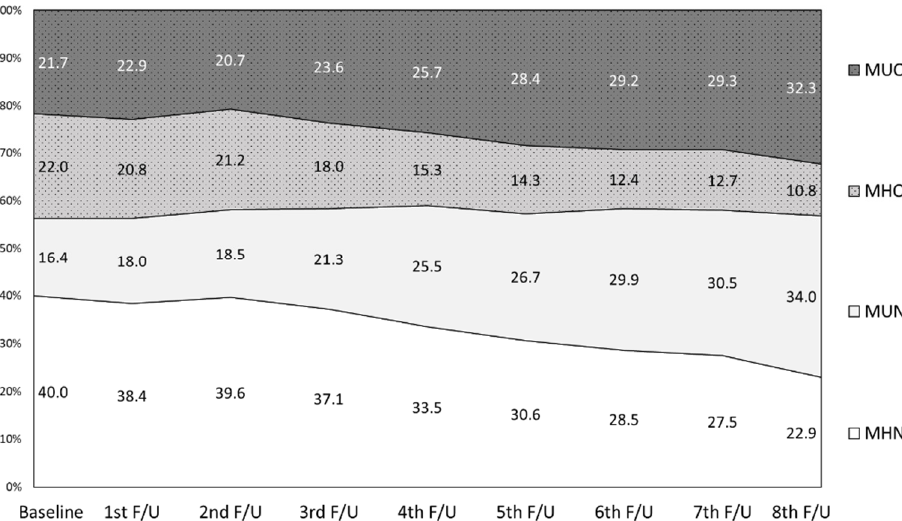
Figure 2. Transition of the combination of metabolic health risk and obesity during the follow-up period. Data were analyzed for those that had data for baseline and all 8 follow-up examinations ( n = 3995). MHN: metabolically healthy non-obese; MHO: metabolically healthy and obese; MUN: met-